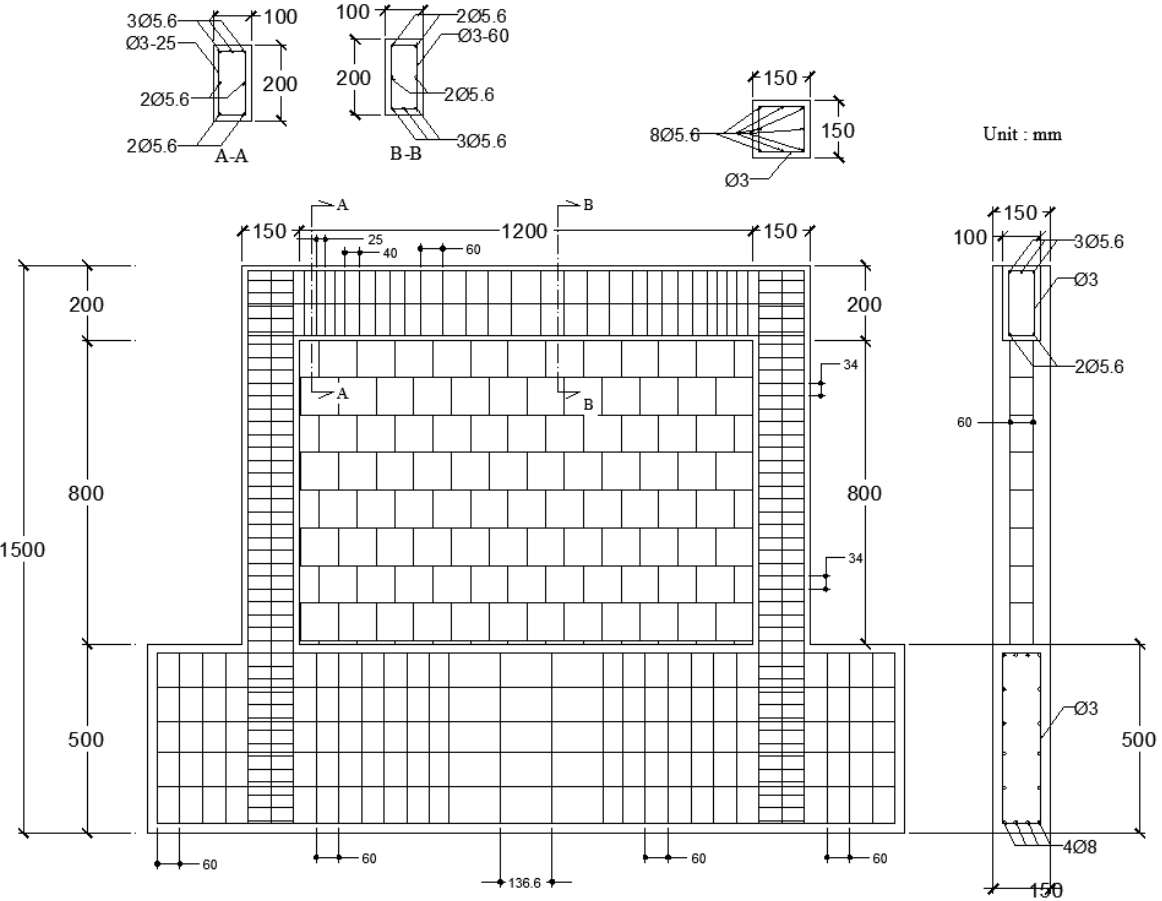
Figure 2. Construction details of the infilled frame specimen used in Kakaletsis experimental test.